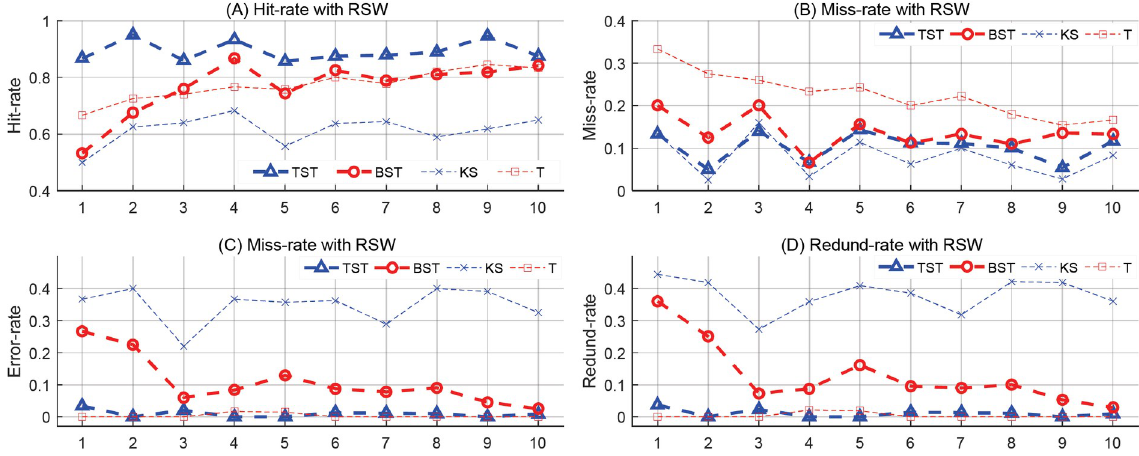
Fig 4. The results of MCPs detection on a series of synthetic time series in the RSW approach. For different numbers of MCPs from 30 to 120, the trend analyses on (A) Hit-rate, (B) Miss-rate, (C) Error-rate, and (D) Redund-rate, are illustrated by using TST, BST, KS and T methods